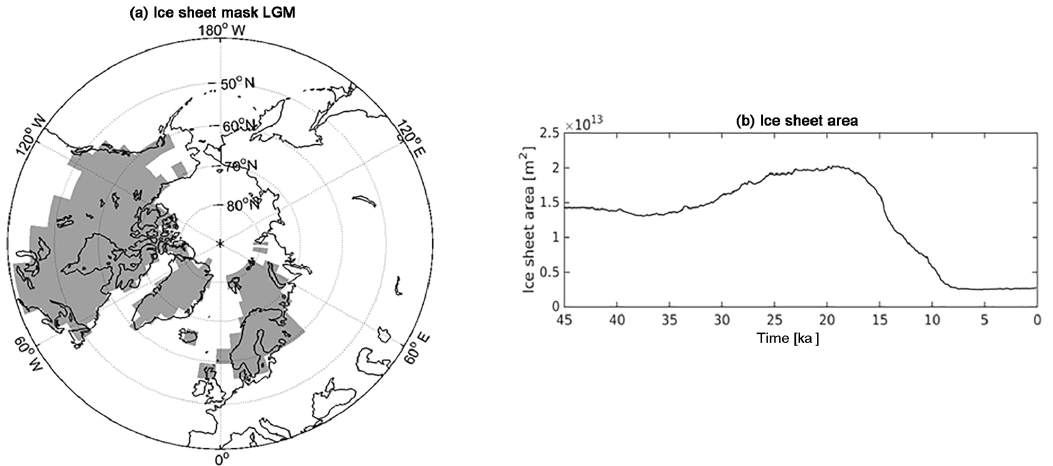
Figure A6. (a) Ice sheet extent at LGM prescribed in MPI-ESM1.2T31_LGM, and (b) evolution of total NH ice sheet area from 45ka to PI simulated by CLIMBER-2.